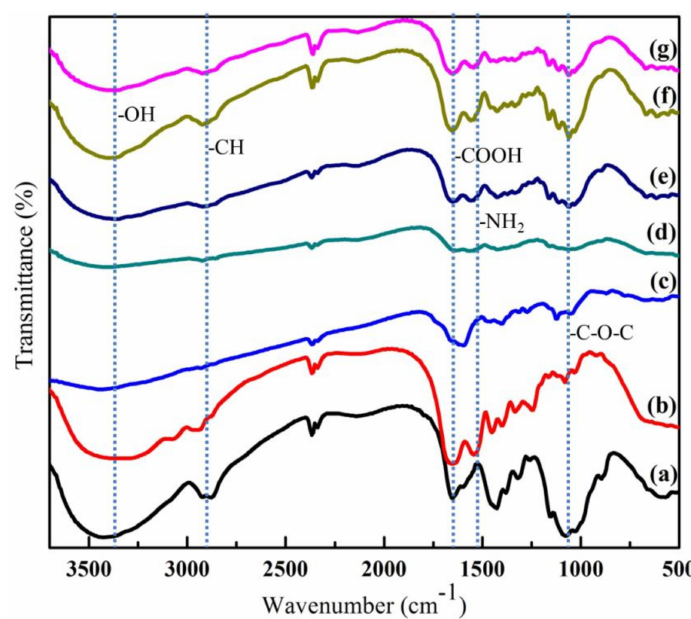
Figure 2. FTIR spectra of ( a ) chitosan, ( b ) collagen, ( c ) bacterial cellulose, ( d ) BC / Chi, ( e ) BC / Col, ( f ) BC / Chi / Col, and ( g ) BC / Col / Chi.